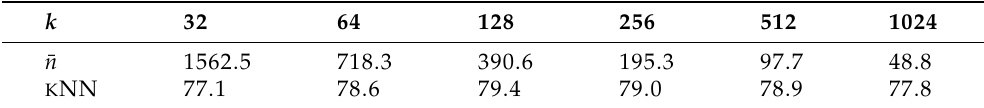
Figure 5. For N = 50,000 and β = 1.5, the performance of our algorithm under various cluster number k . In both ( a , b ), for all k , convergence needs only around 20 iterations or fewer and the final distributions are quite uniform. Table 14. CIFAR-10: Evaluations for different k .